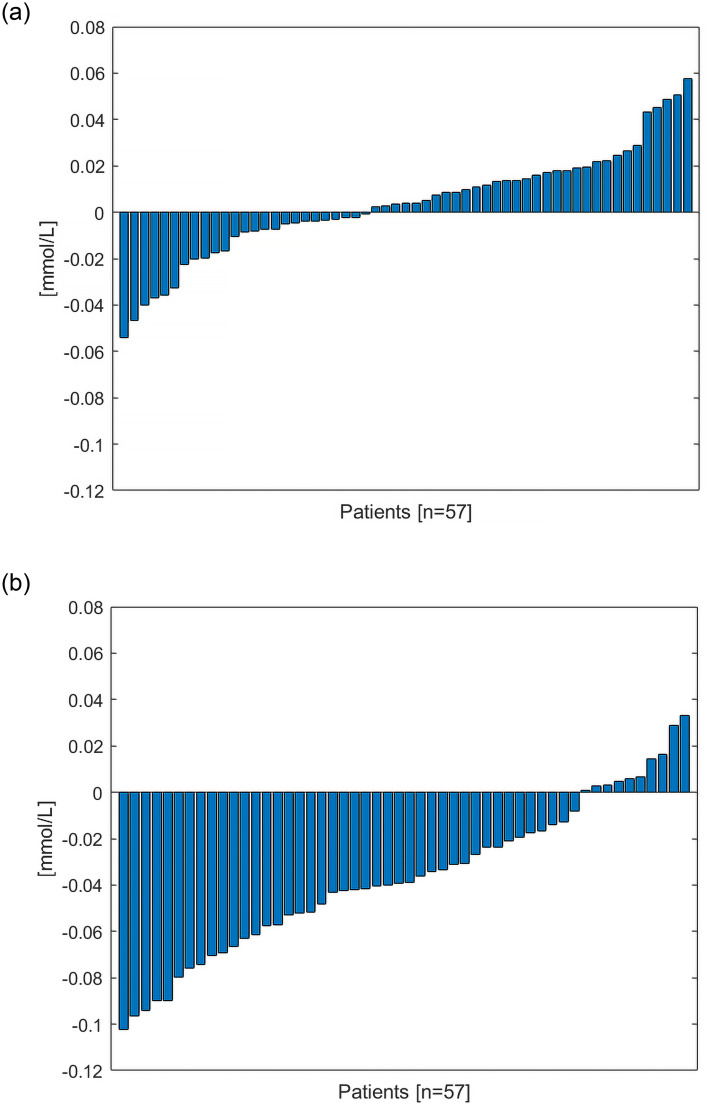
Average differences between measured post-filter iCa and calculated post-filter iCa for quality checked data for Algorithm 1 (2a) and Algorithm 2 (2b).There are instances when the algorithms are returning values both higher and lower to the BGA. Algorithm 2 has a tendency to underestimate postfilter iCa, while Algorithm 1 does not seem to have the same tendency.